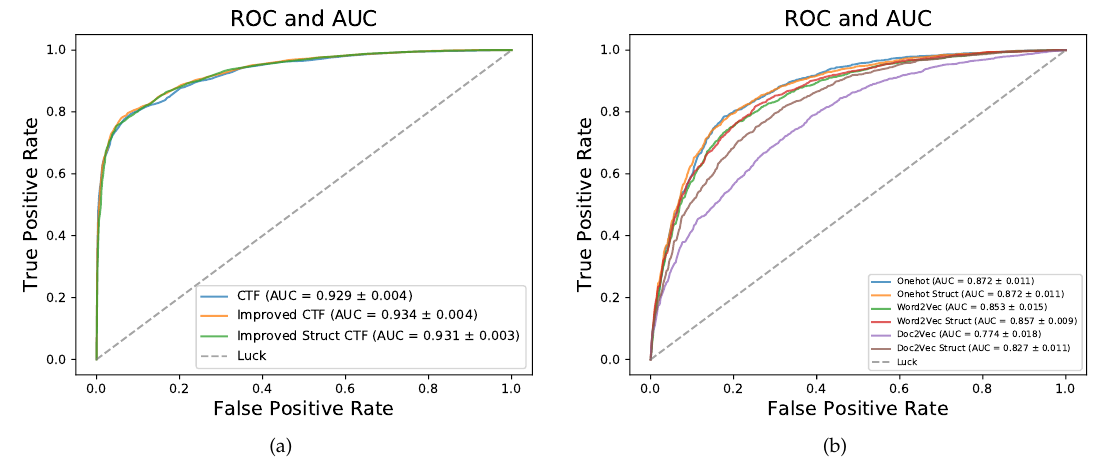
Figure 2. ROC and AUC comparison between different sequence coding methods on dataset RPI2241 by five-fold cross validation. ( a ) CTF, Improved CTF and Improved Struct CTF; ( b ) One hot, word2vec and doc2vec.